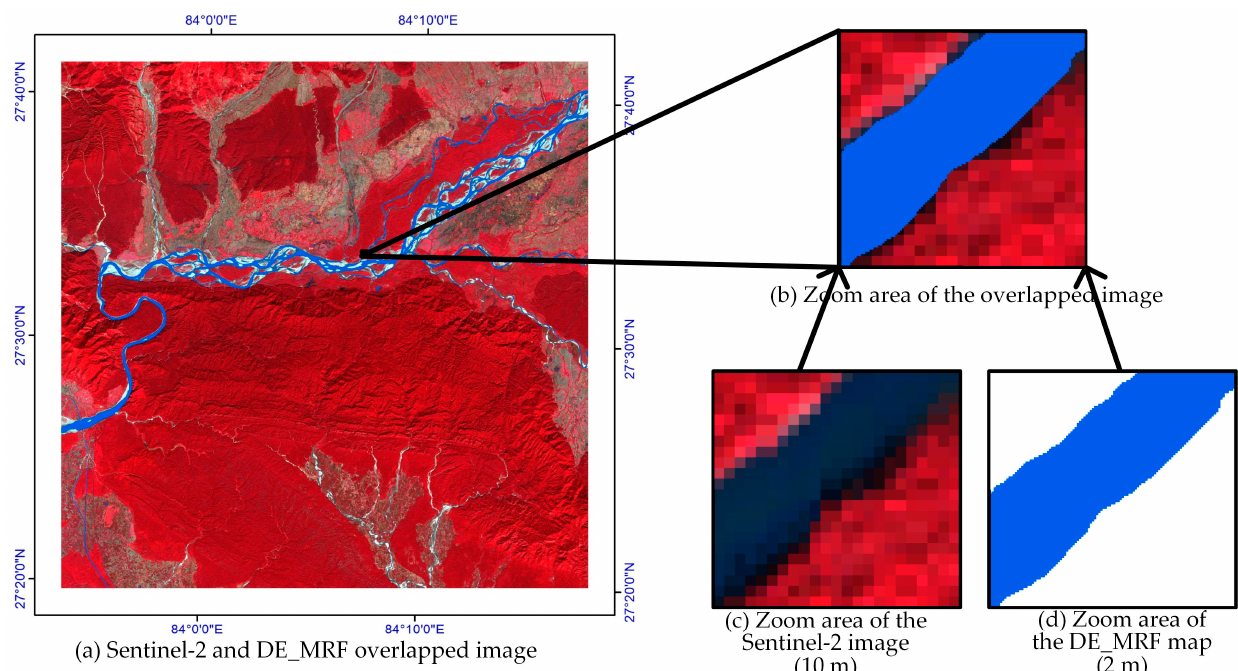
Figure 9. 2 m resolution DE_MRF surface water map (blue indicates surface water, and white indicates land) overlapped with the Sentinel-2 image in the Dangara region in Guinea. The false color image is composited with VNIR-red-green as RGB.